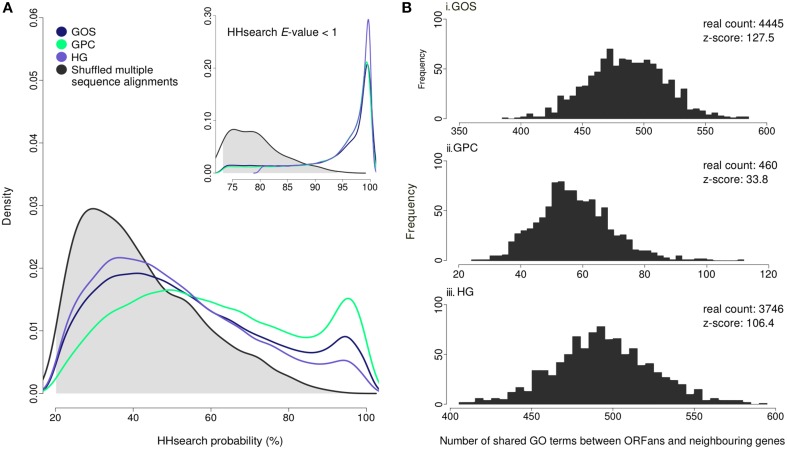
Estimated false discovery rate of ORFan remote homology detection and functional prediction. (A) Distributions of HHsearch probability scores for ORFans from three metagenomes, and shuffled sequences, searched against a PDB-derived HMM library. There is an abundance of high-scoring predictions (i.e., above 80% probability) for ORFan proteins compared to the expected (null) distribution. This separation becomes even greater when an HHsearch E-value threshold of 1 is applied (see inset). (B) The number of shared GO terms between functionally annotated ORFans (probability scores >80%) and their metagenomic neighbors (see Materials and Methods) is shown for three metagenomes. The null distributions, as estimated by randomly shuffling ORFan identities/positions, are shown along with the z-scores relative to these distributions. The mean values for the random distributions are: GOS (486.3), GPC (57.8), and HG (494.4).